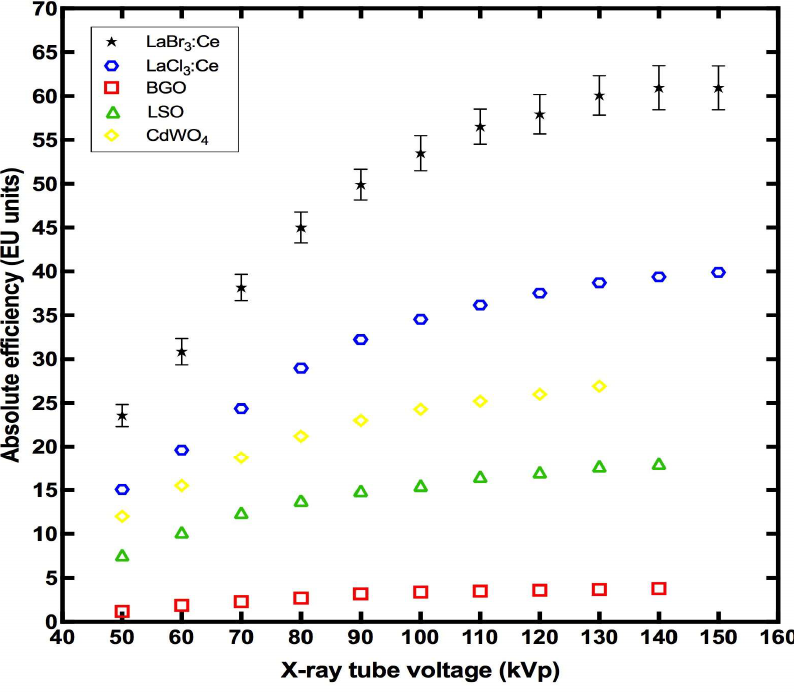
Figure 6. AE values of the LaBr 3 :Ce (4.25% error bar) crystal in comparison with previously published data for the LaCl 3 :Ce, BGO, LSO and CdWO 4 crystals.